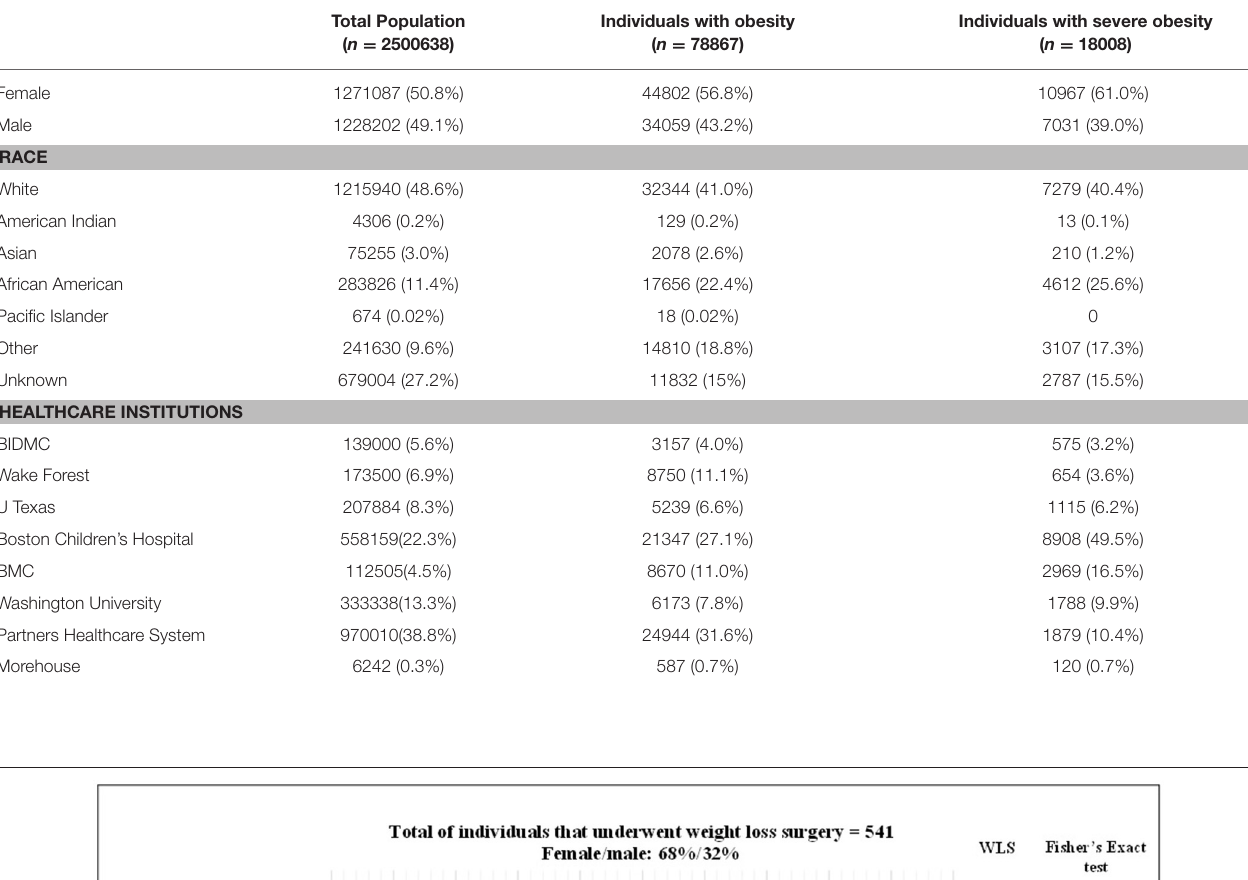
TABLE 1 | Demographics of individuals by gender, race and healthcare institution.